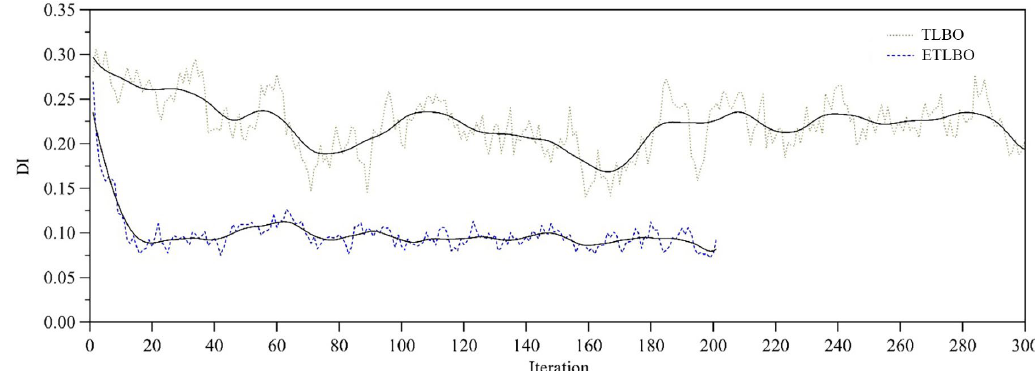
Figure 14. DI traces of ETLBO vs. TLBO for the 112-bar